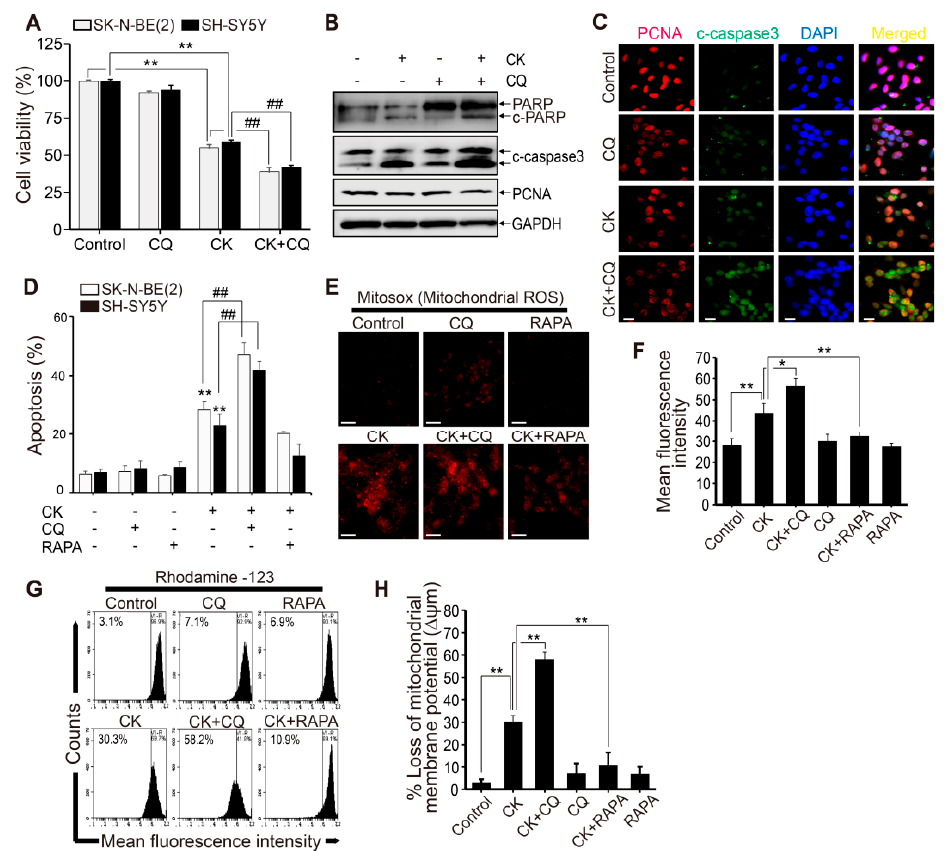
Figure 7. Inhibition of autophagy promotes CK-induced apoptosis via mitochondrial membrane ROS and mitochondrial membrane potential loss in human neuroblastoma cells. ( A – D ) Cells were pretreated with 10 µ M CQ for 3 h prior to the treatment with CK 5 µ M for 24 h. (A) SK-N-BE(2) and SH-SY5Y cell viability was determined by CCK-8 assay after 24 h incubation. ( B ) The protein levels of PARP, cleaved caspase-3, and PCNA in SK-N-BE(2) cells were analyzed by western blot. ( C ) Immunostaining was performed with cleaved caspase-3 and PCNA antibodies in SK-N-BE(2) cells. ( D ) Apoptotic cell death was evaluated by Annexin V / PI analysis with flow cytometry in SK-N-BE(2) and SH-SY5Y cells. Data ( A ) and ( D ) are presented as mean ± SD. **: p < 0.01 versus control cells, and ##: p < 0.01 versus CK-treated cells. ( E , F ) SK-N-BE(2) cells were treated with 5 µ M CK with or without CQ (10 µ M) or rapamycin (RAPA) (100 nM) for 24 h. ( E ) The MitoSOX ™ Red fluorescence intensity was detected by fluorescence microscopy. (F) The corresponding histograms were quantified by Image J. All data are represented as mean ± SD (N = 3) for each group. *: p < 0.05, **: p < 0.01. ( G ) To determine mitochondrial membrane depolarization, SK-N-BE(2) cells stained with Rhodamine123 dyes were analyzed by flow cytometry. ( H ) Data are presented as mean ± SD (n = 3) for each group. **: p < 0.01. CK, Ginsenoside compound K; CQ, chloroquine.